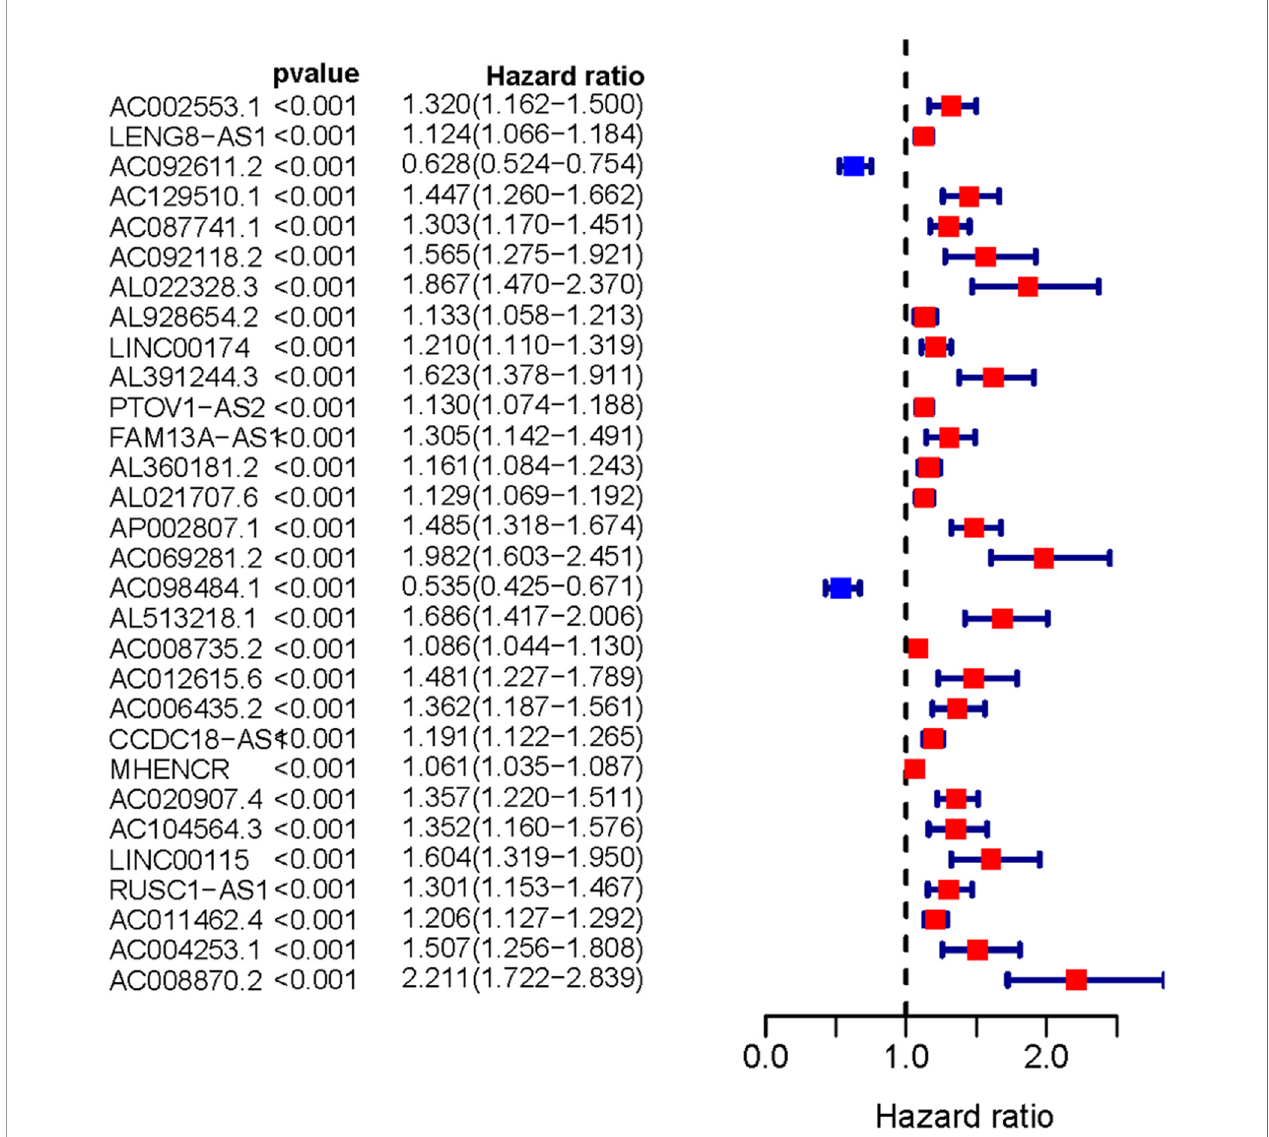
FIGURE 1 | Survival-related ARLNRs forest plot. The hazard ratios of survival-related ARLNRs (AC002553.1, LENG8-AS1, AC092611.2, AC129510.1, AC087741.1, AC092118.2, AL022328.3, AL928654.2, LINC00174, AL391244.3, PTOV1-AS2, FAM13A-AS1, AL360181.2, AL021707.6, AP002807.1, AC069281.2, AC098484.1, AL513218.1, AC008735.2, AC012615.6, AC006435.2, CCDC18-AS1, MHENCR, AC020907.4, AC104564.3, LINC00115, RUSC1-AS1, AC011462.4, AC004253.1, and AC008870.2) were showed in the forest plot. Red parts represent upregulated sARLNRs, and green parts represent downregulated